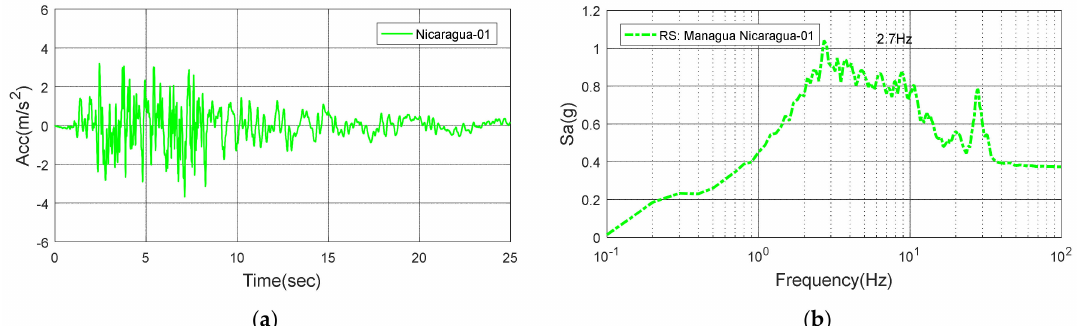
Figure 17. Nicaragua-01: ( a ) Time history; ( b ) Response